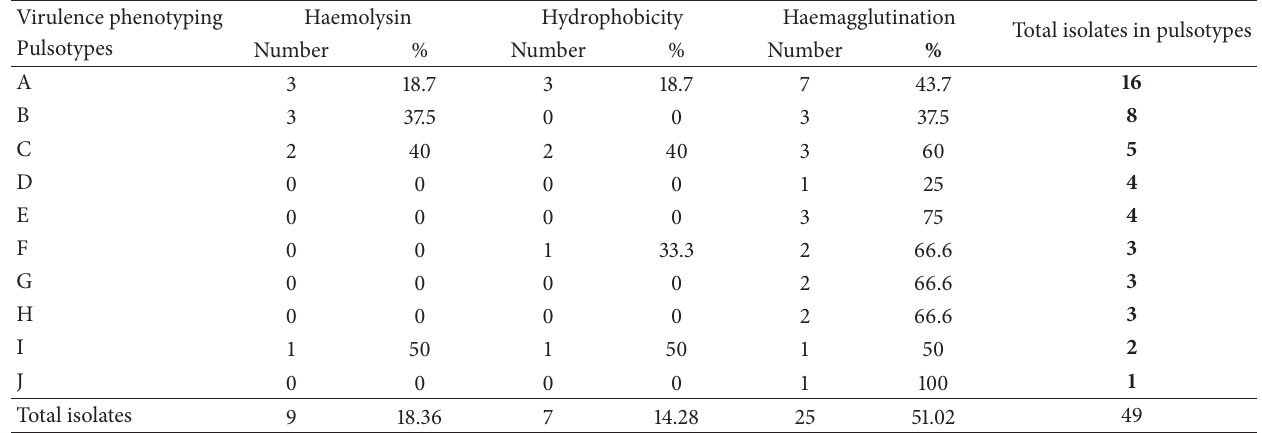
Table 2: Distribution of virulence phenotyping in pulsotypes.